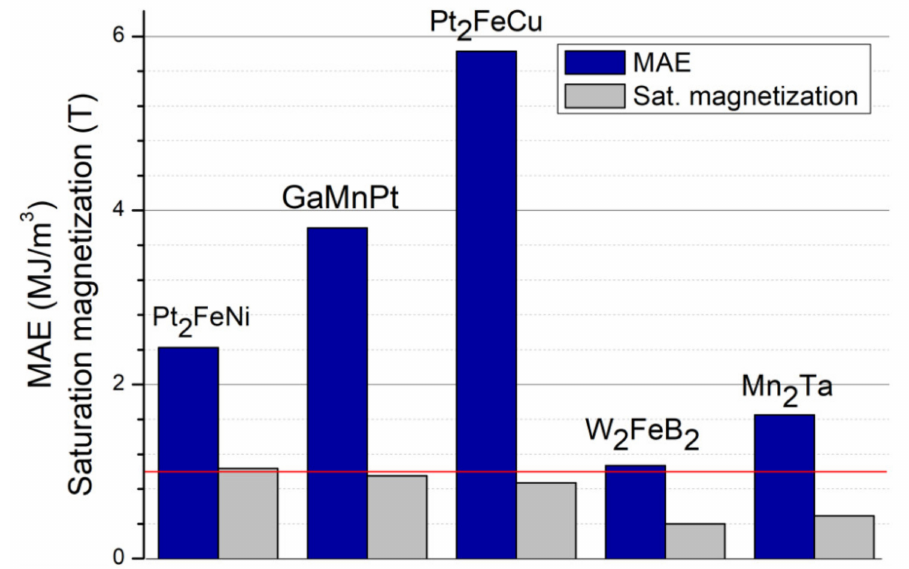
Figure 2. Magnetocrystalline anisotropy energy and saturation magnetization (polarization) of previously researched (Pt2FeNi) of potential candidates for PM. Red line indicates the threshold for a potentially successful PM. Further information available in [16]. This article or its components is available under the terms of the Creative Commons Attribution 4.0 International License (https://creativecommons.org/licenses/by-nc-sa/4.0/ accessed on 12 March